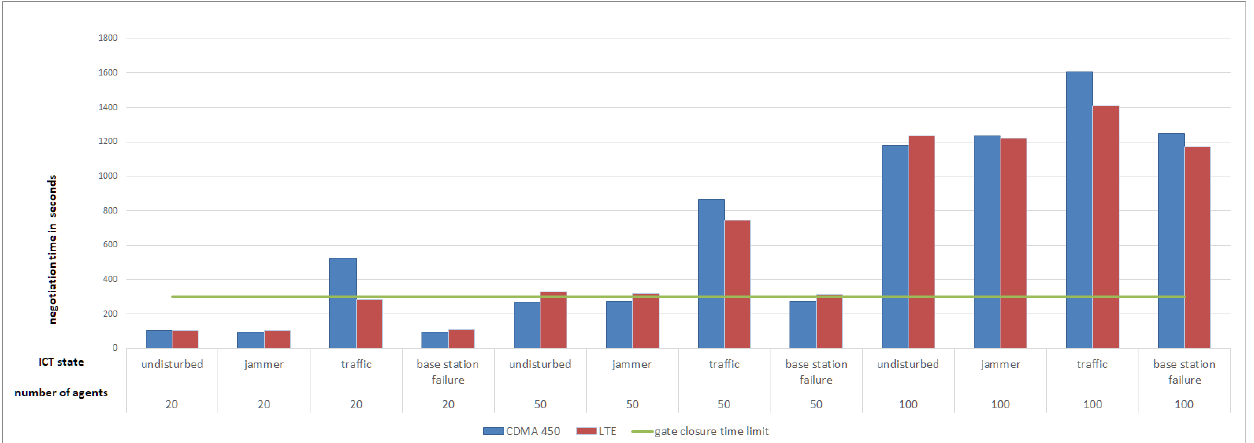
Figure 11. Negotiation time of experiments with a relaxed objective function for both communication technologies and different scenarios. From left to right: the scaled numbers of agents in the VPP for the different ICT